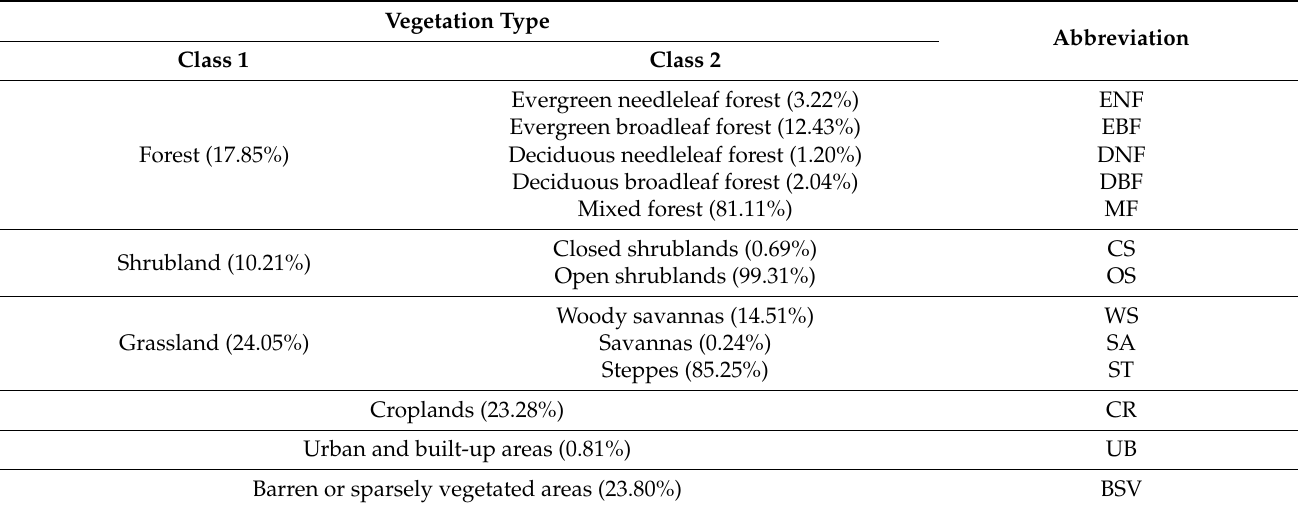
Table 1. Proportions of different land-cover